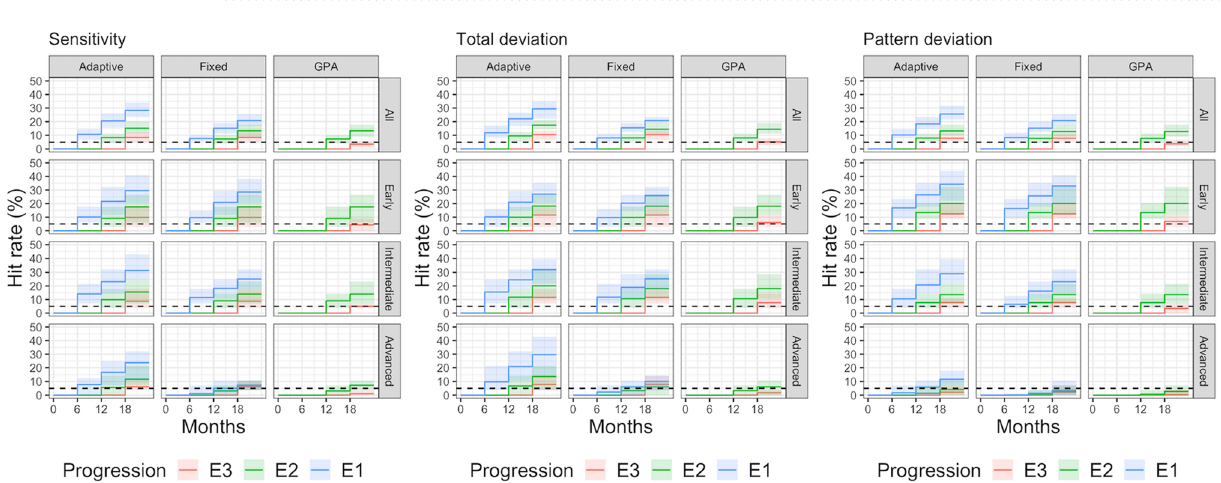
Figure 3. Cumulative percentage of HR of the three progression analyses (Adaptive rule, Fixed rule and GPA), for sensitivities (left), Total Deviation (centre) and Pattern Deviation (on the right). Cumulative detection rates are reported for each follow-up visit (6, 12 and 18 months) and for each progression type (E1, E2 and E3). The horizontal dashed line indicates 5%